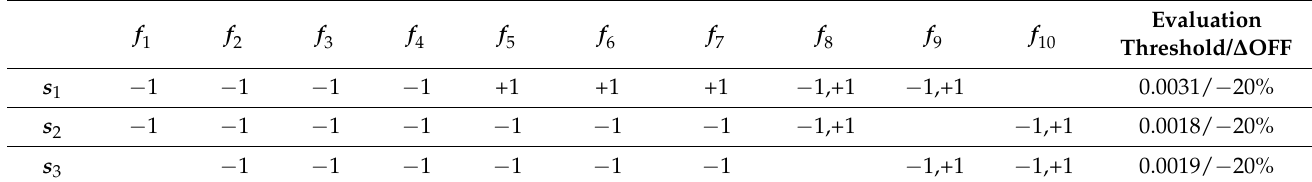
Table 3. FIS—Fault Isolation System.